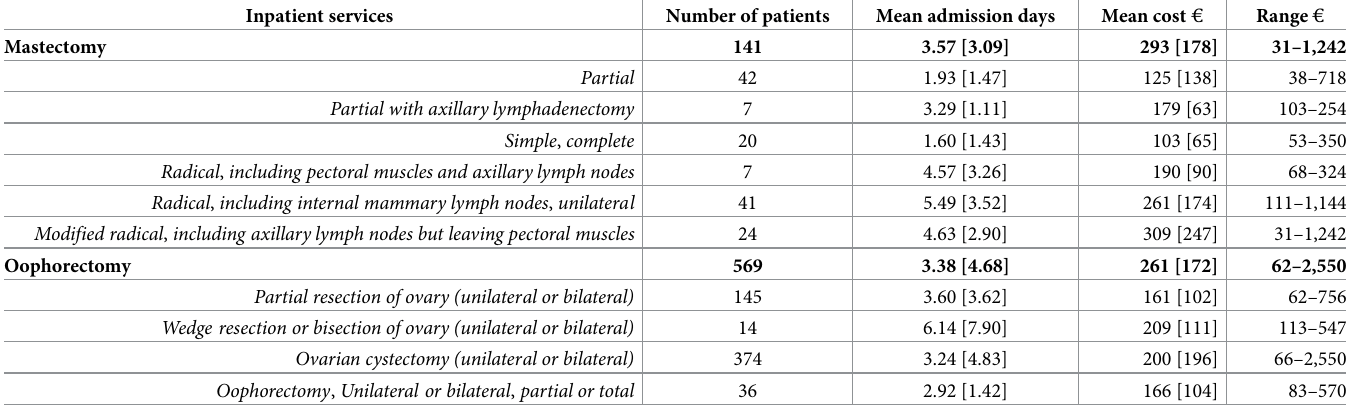
Table 3. Average costs of mastectomy and oophorectomy. (Costs as of 20.03.2014; 1 € = 34,000